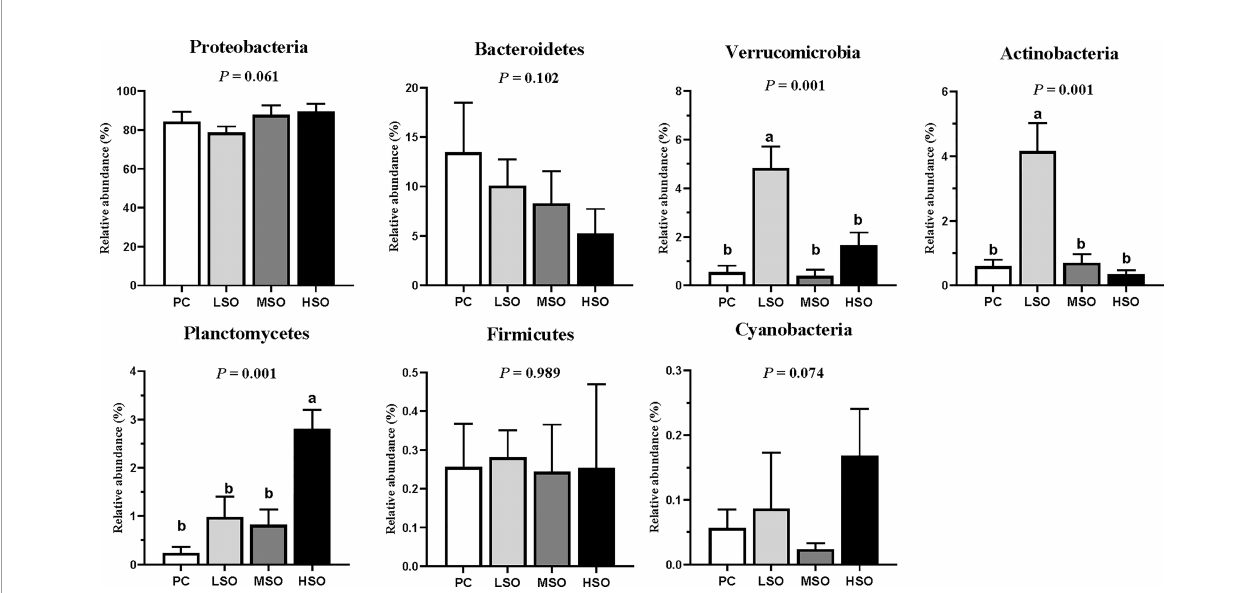
Data represent mean ± SD of three replicates (n = 3). Values with different superscripts in rows indicate signi fi cant difference (p < 0.05) based on Tukey ’ s multiple test. The lack of superscript letter indicates no signi fi cant differences among groups.